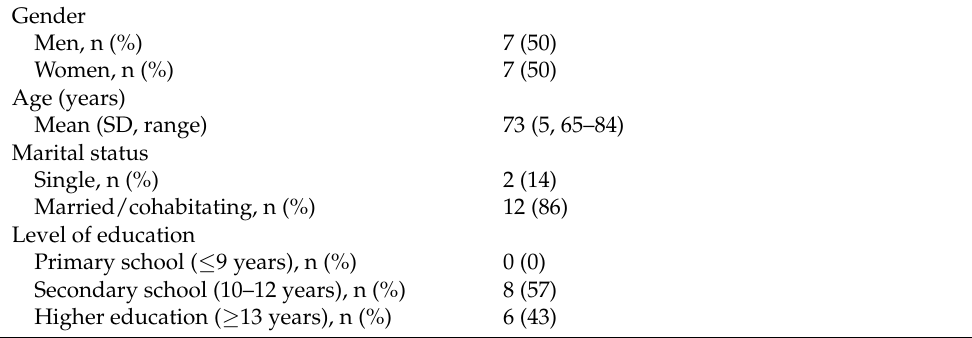
Table 1. Characteristics of the 14 participants with Late Effects of